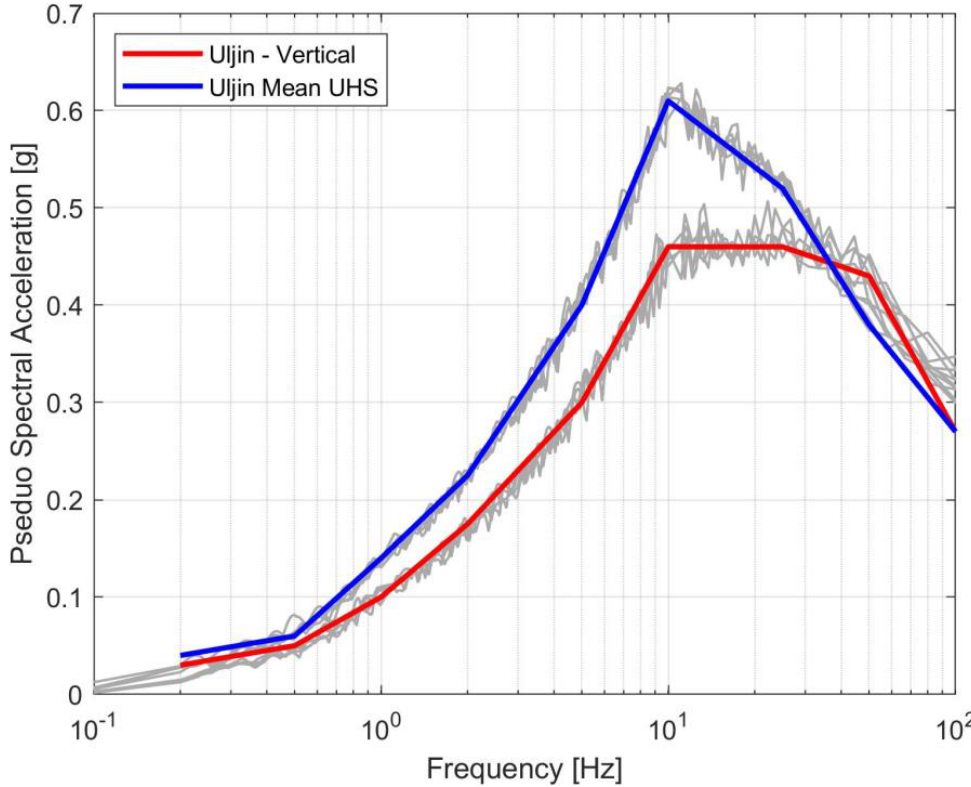
Figure 1. Ground motion pseudospectral acceleration.